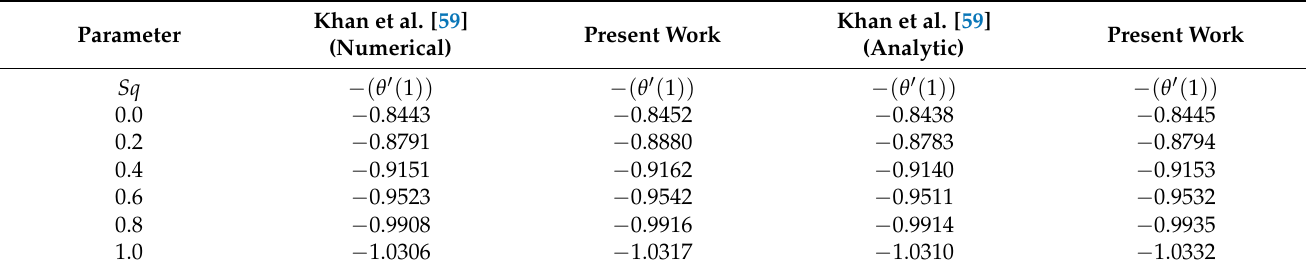
Table 4. The comparative assessment of present outcomes with the published literature for Nusselt number –( θ (cid:48)